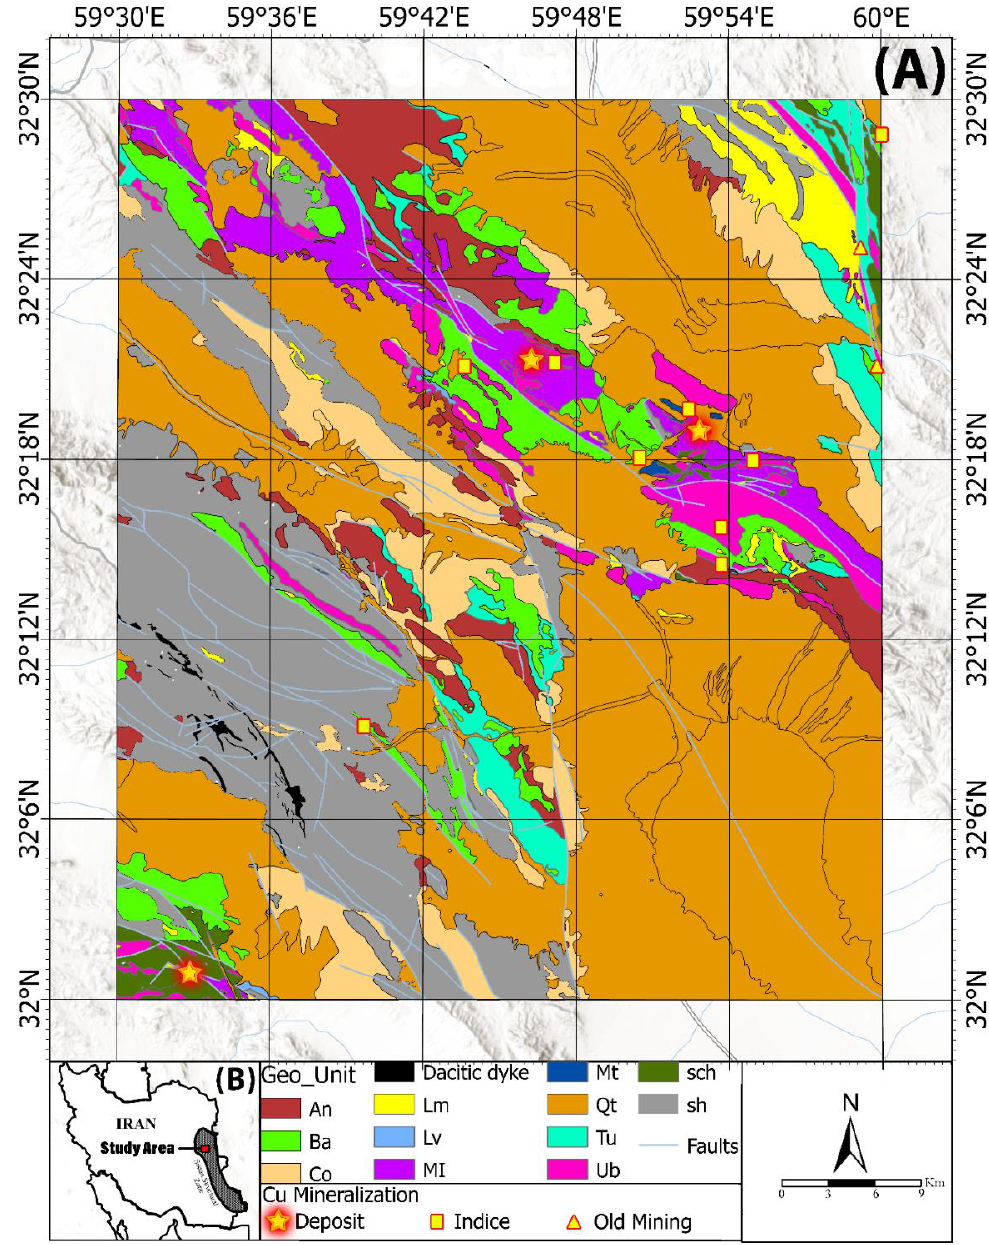
Figure 1. ( A ) Geological map of Sahlabad area (scale of 1:100,000) (modified [39]). Abbreviations: An = Andesite, Ba = Basalt, Co = Conglomerate, Dd = Dacitic dyke, Lm = Limestone, Lv = Listwanite, Ml = Ophiolite melange, Mt = Metadiabase, Qt = Quaternary sediments, Tu = Tuff, Ub = Ultrabasic rocks, Sch = Schist, Sh = Shale and sandstone. ( B ) Geographical location of Sistan structural zone in Iran.